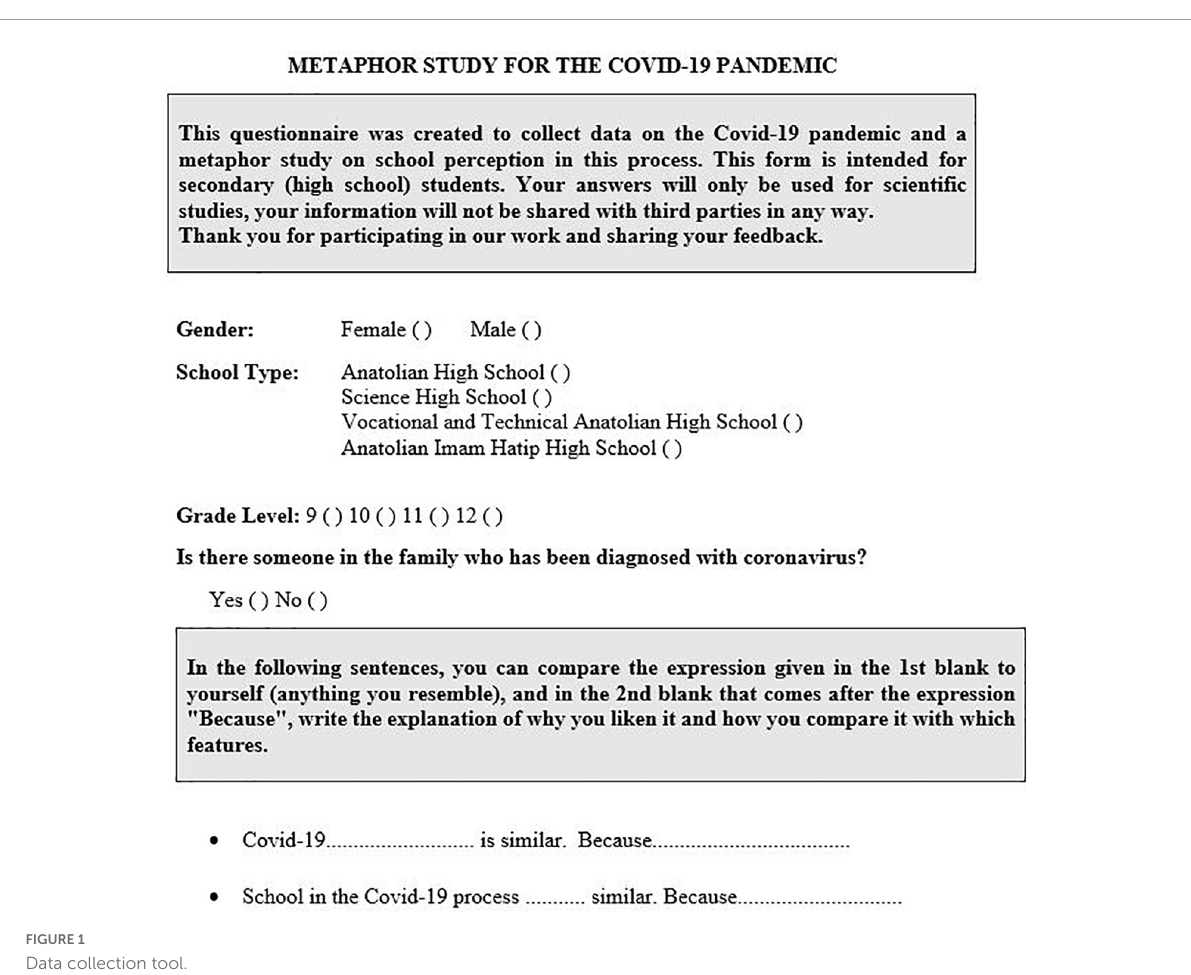
FIGURE1 Data collection